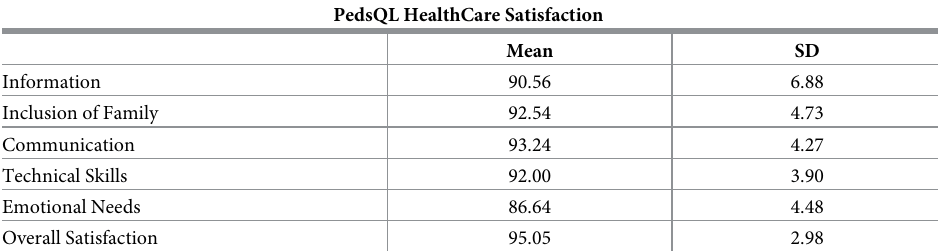
Table 3. Scale descriptives for PedsQL TM Healthcare Satisfaction Generic Module.